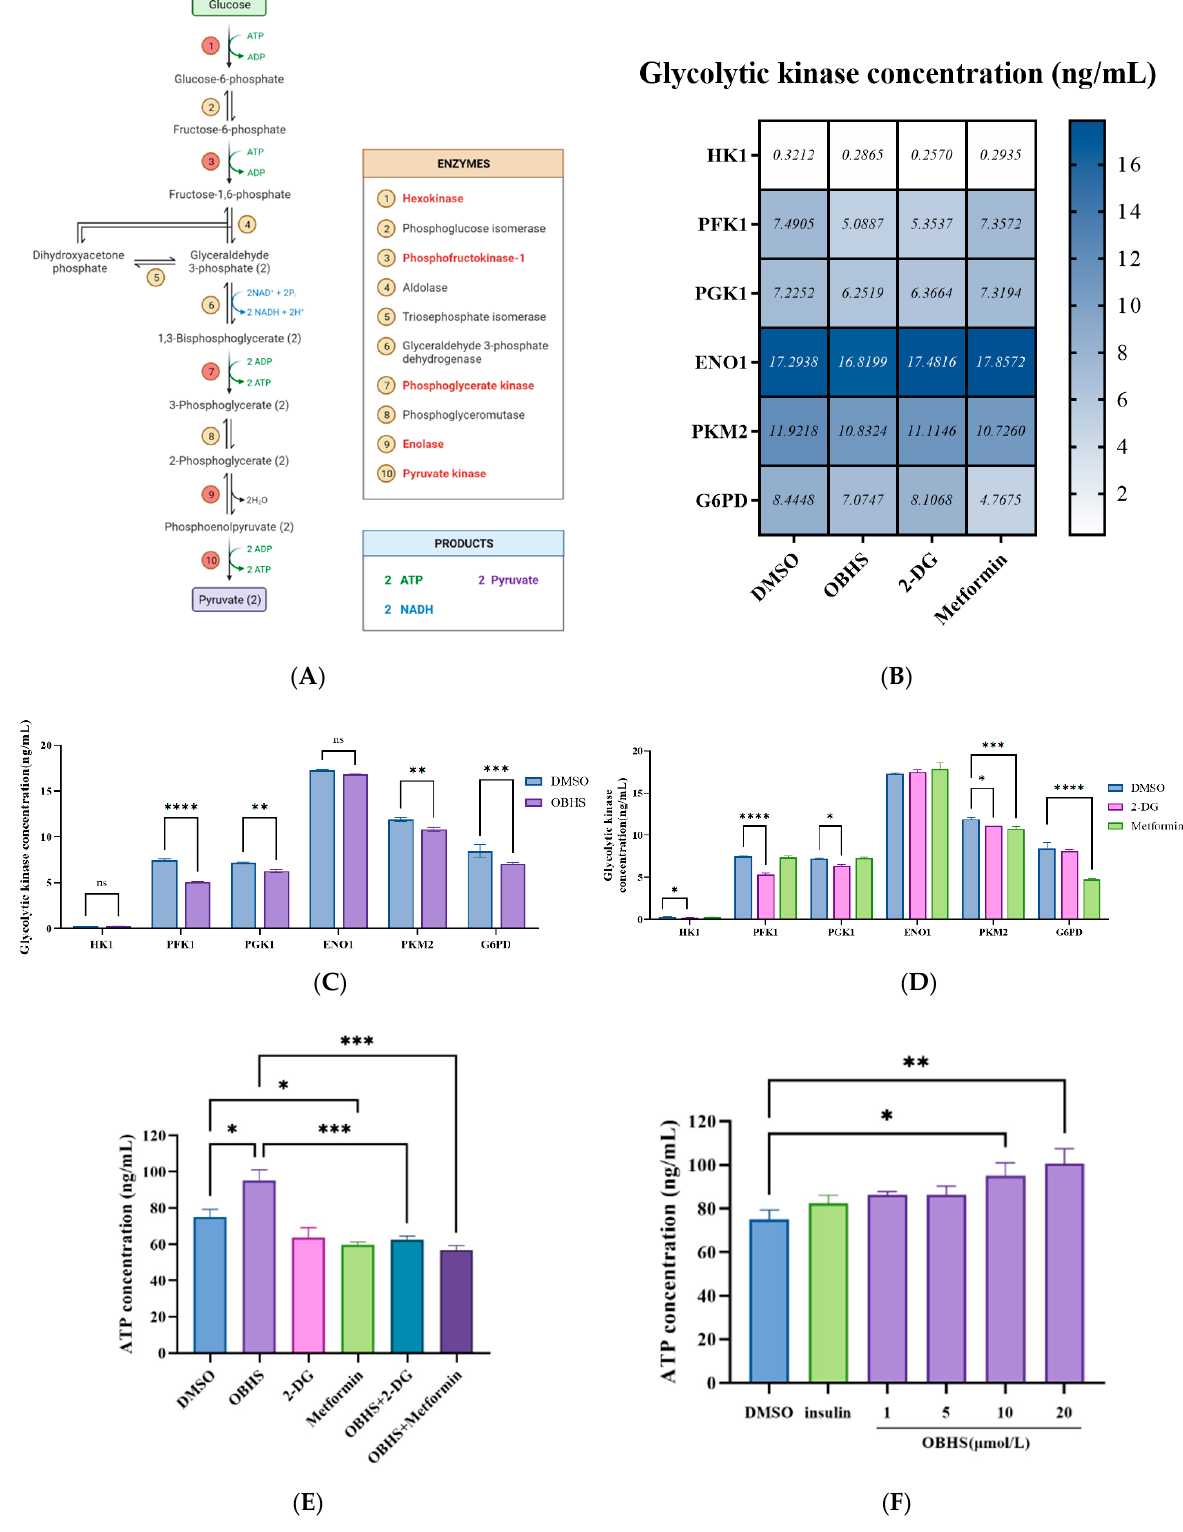
Figure 4. OBHS regulates glucose and oxidative phosphorylation-related enzyme concentration among glycolytic and PPP. ( A ) A schematic diagram of the glucose metabolic flux. ( B ) Heat map depicting the effects of OBHS, 2-DG, and metformin on the enzymes concentration. The mean value were marked in each cell. The cells were treated with ( C ) OBHS (purple bars), ( D ) 2-DG (pink bars), and metformin (light green bars) for 24 h, and the supernatant of cell lysates was collected after repeated freezing and